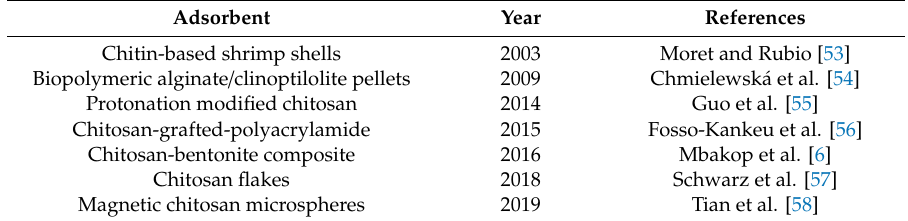
Table 1. Summary of various chitosan / alginate-based sorbent materials reported in the literature for the removal of SO 42 − species from aqueous